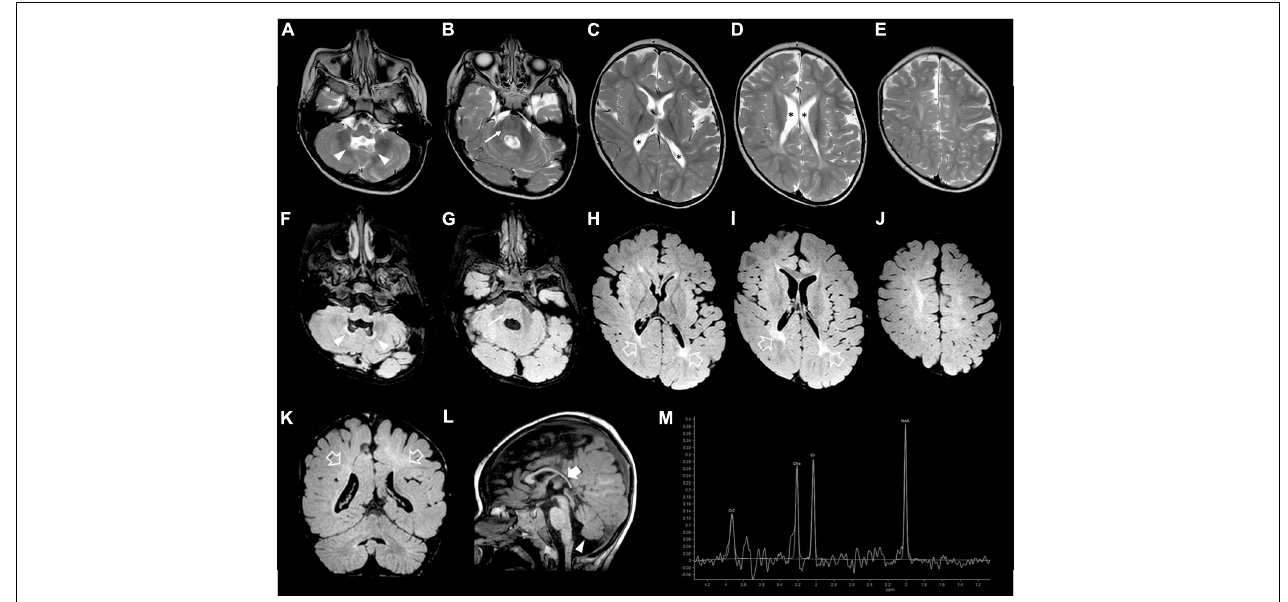
FIGURE 3 | Brain MRI and MR spectroscopy were performed at 2 years and 4 months of age. (A–E) Axial T2-weighted, (F–J) axial FLAIR, and (K) coronal FLAIR images show mild evolution of the brain atrophy with white matter volume reduction and diffuse signal alterations, accentuated in the posterior periventricular regions (empty arrows). Note the squared lateral ventricles (asterisks). There are mild T2/FLAIR hyperintensities also at the level of the pons (arrows) and cerebellar dentate nuclei (arrowheads). (L) Sagittal T1-weighted image depicts marked thinning of the posterior sections of the corpus callosum (thick arrow), and inferior cerebellar vermis hypoplasia (arrowhead). (M) Brain MR spectroscopy performed at the level of the right basal ganglia shows a slightly reduced NAA peak and absence of lactate